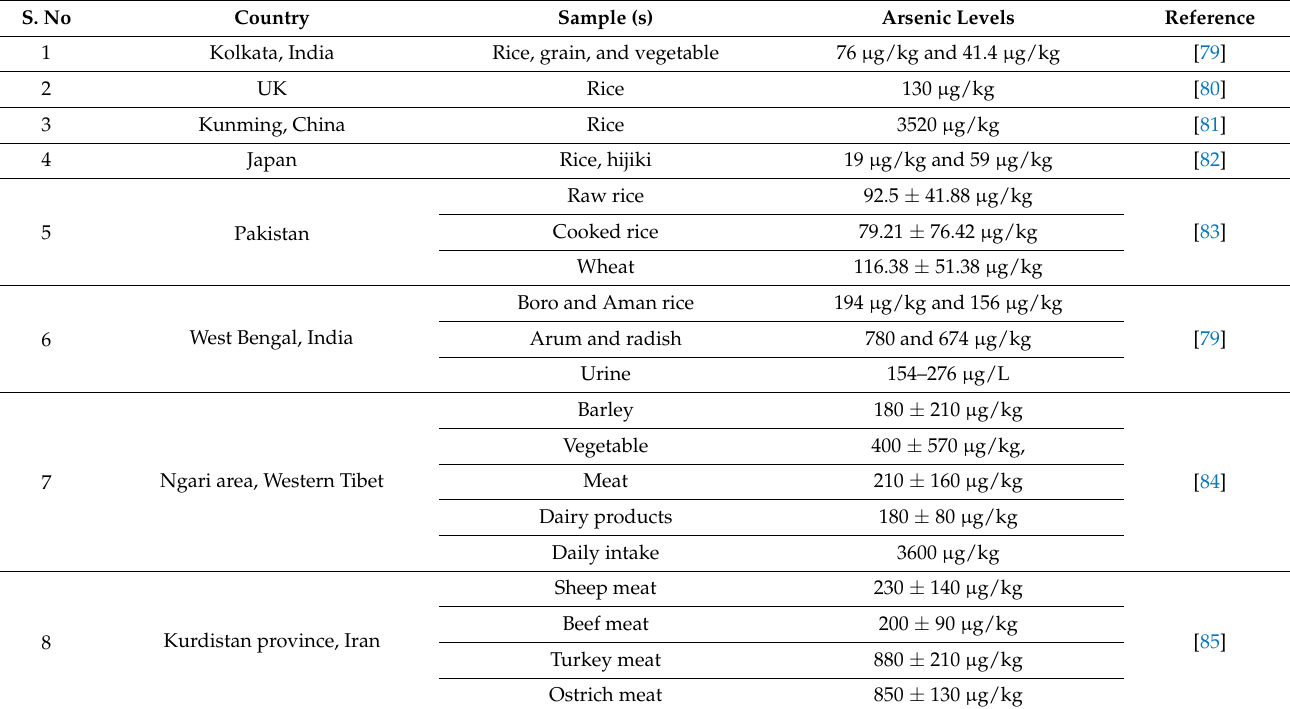
Table 2. Evidence from research findings indicates the presence of arsenic in grains, vegetables, dairy products, and meat which increases the risk of